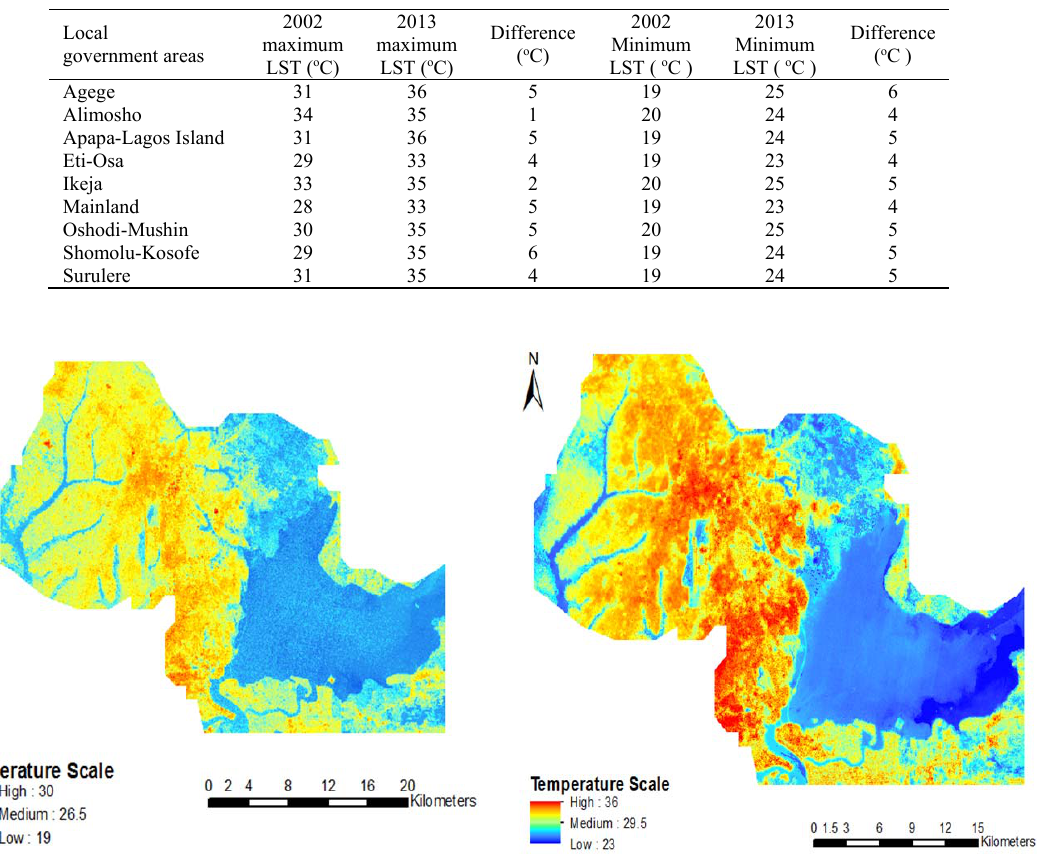
Fig. 4: Land surface temperature map for all local government areas (2002) Fig. 5: Land surface temperature map for all local government areas (2013)